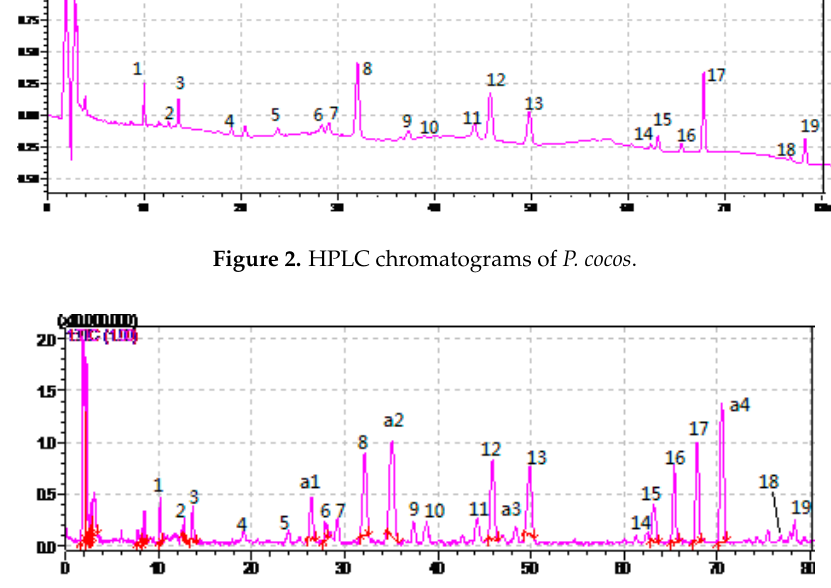
Figure 3. Positive mode of the HPLC-MS n chromatograms of P. cocos .